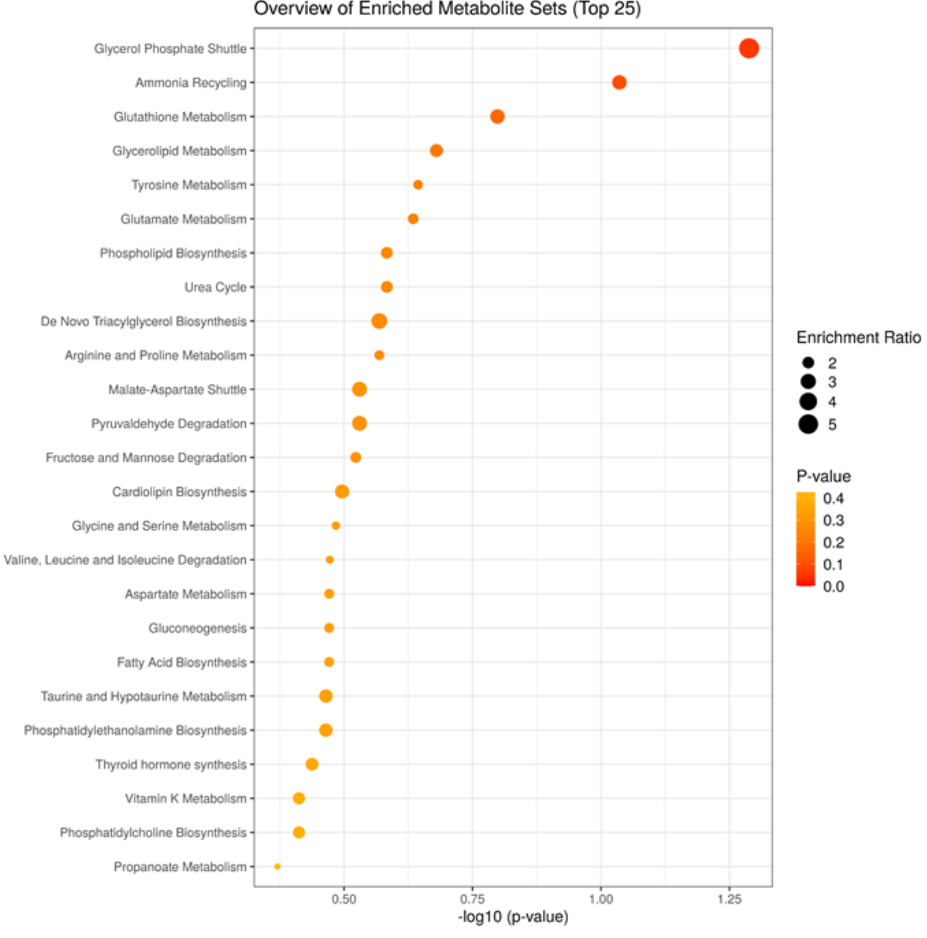
Figure 4. Metabolic pathways showing the interplay of selected metabolites.